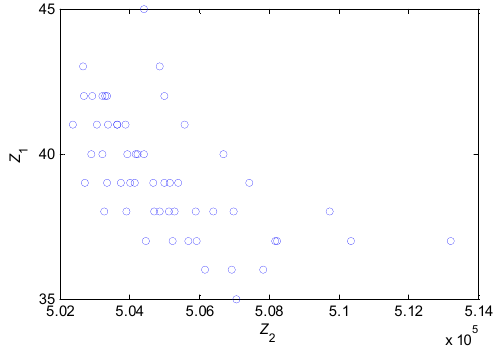
Figure 2. Running results of GA for 10 times.